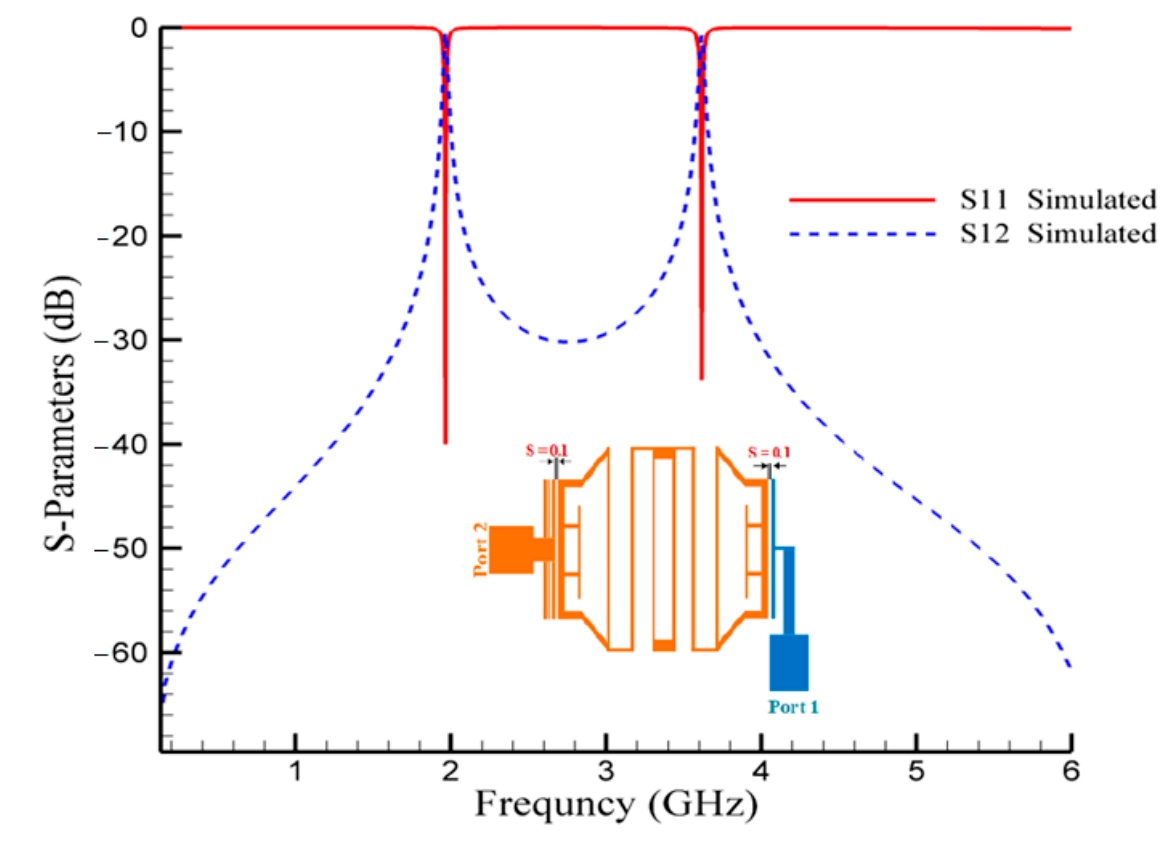
Figure 4. Simulated frequency responses of the first proposed BPF at 1.9/3.6 GHz.